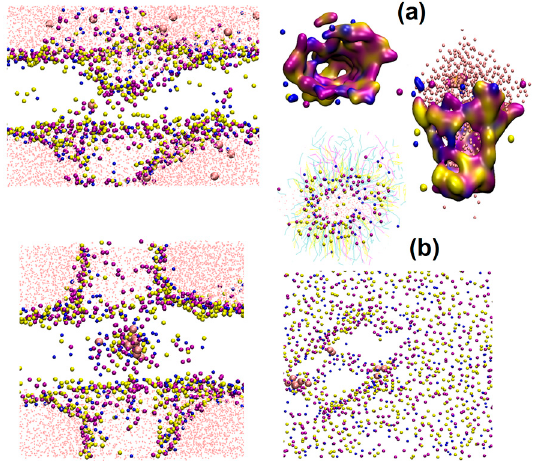
Figure 2. Detailed structures of water pores and reversed micelles formed by borneol in lipid bilayers by CG-MD simulations: ( a ) water pore; and ( b ) reversed micelle.